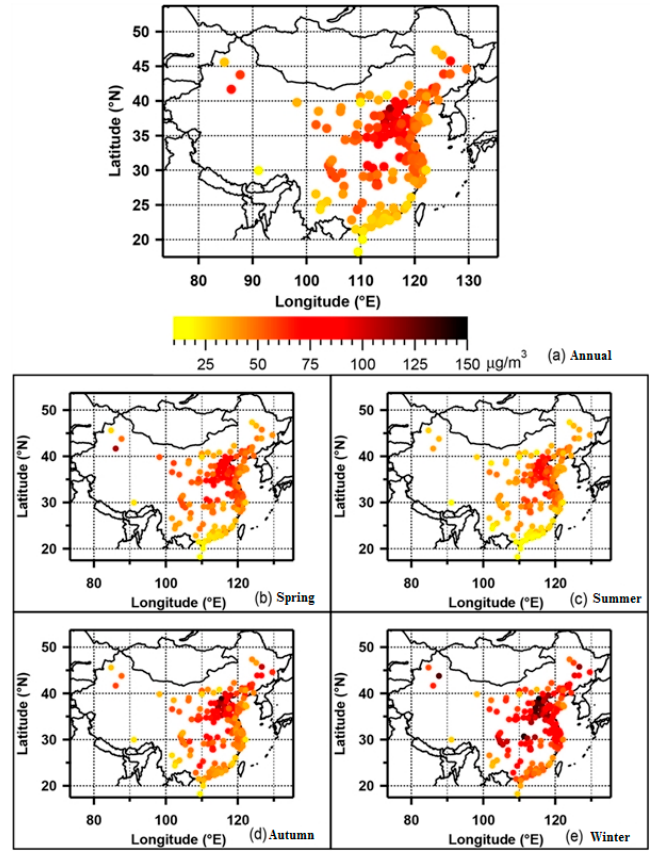
Figure 1. Spatial and temporal distribution of PM 2.5 in Chinese cities [5].